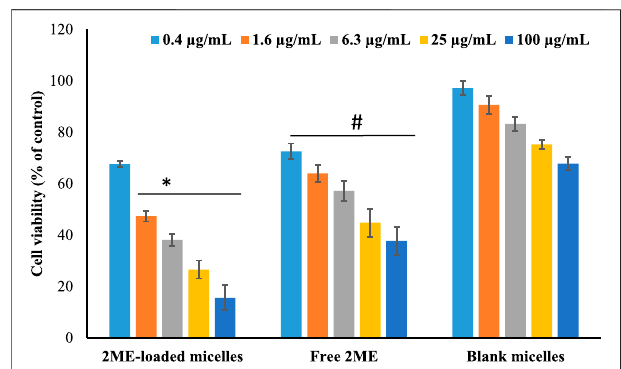
FIGURE 3 | The cumulative release pattern of 2 ME from the optimized 2 ME-loaded mixed micelles in phosphate buffer (pH 7.4). Values are expressed as mean ± SD ( n (cid:2) 3).